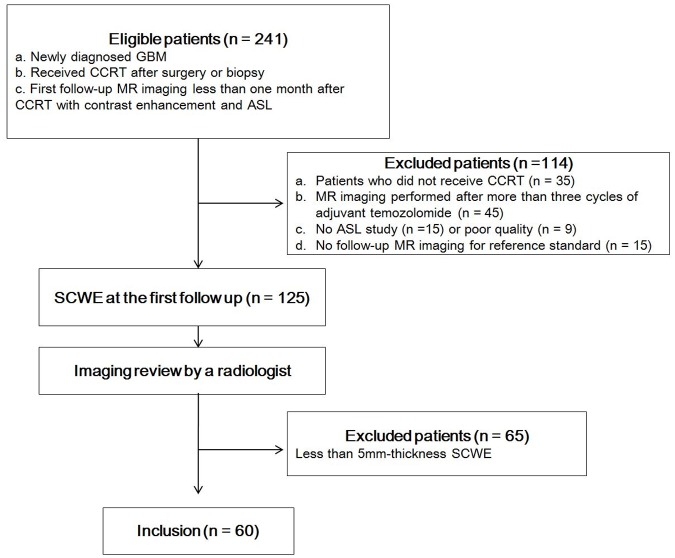
Flow diagram of patient selection.SCWE = surgical cavity wall enhancement.